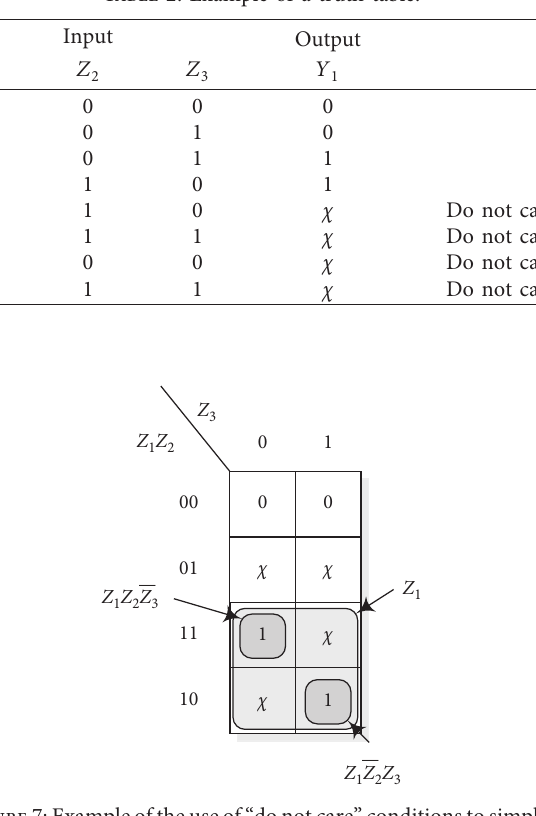
� Z Z Z + Z Z Z . 1 1 2 3 1 2 3